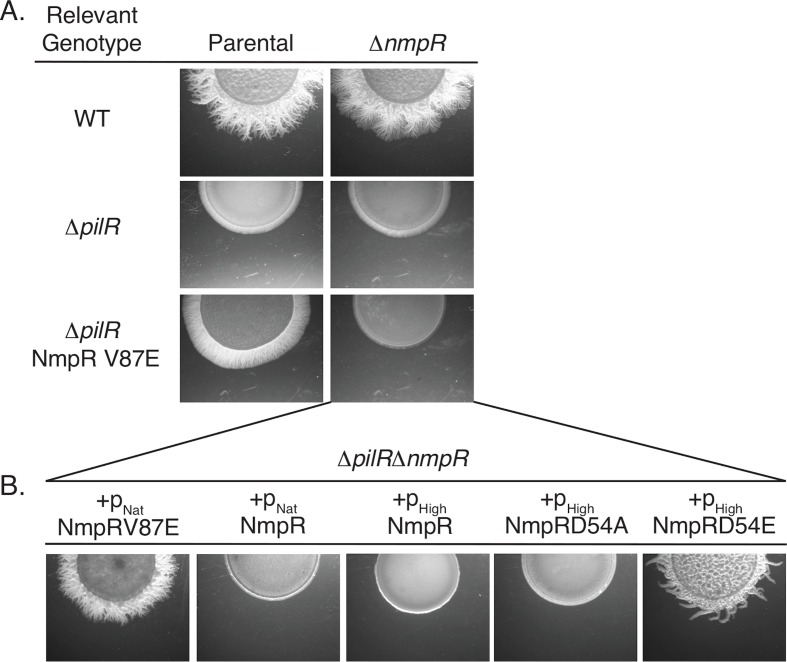
The NmpR V87E suppressor strain has a gain-of-function mutation.(A) In-frame nmpR deletions were constructed in the indicated strains and assayed for motility on 0.5% agar. All images depicted are after two days of motility. (B) Single copy complementation vectors were integrated at the Mx9 phage attB site and resulting strains assayed for motility. The pNat = 585 bp upstream of mxan_4236 (See Fig 2A) and pHigh = 623 bp upstream of mxan_4894, groES [43, 44] (See S1 Fig). D54A is an unphosphorylatable form of NmpR and D54E is a phosphomimetic.